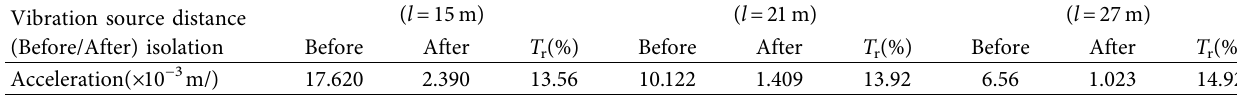
Table 3: Vibration comparison with and without vibration isolation system in different source distances.